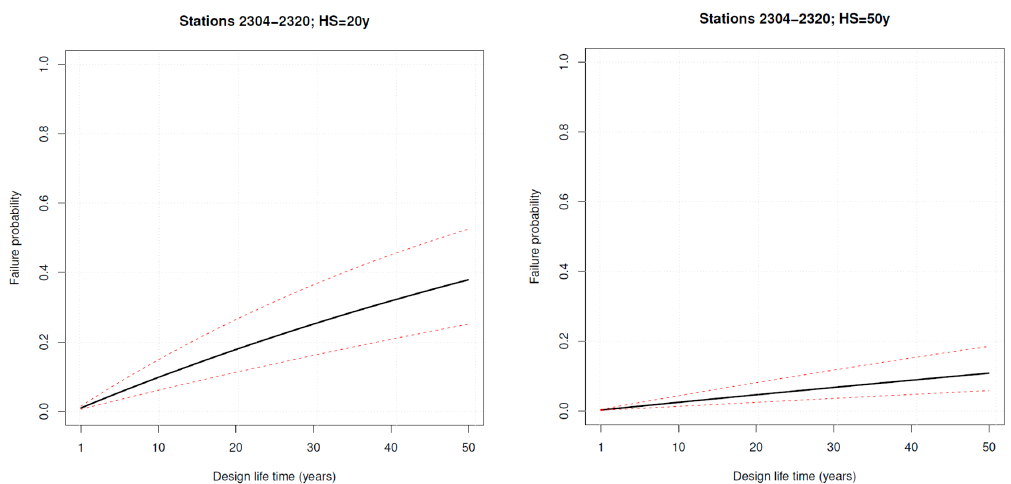
Figure 11. Upper Çoruh basin. Failure probabilities for given design life times; the dashed red lines indicate a 95% confidence band. The different plots correspond to the probability that the system enters a bivariate AND hazard scenario whose marginal critical thresholds are given by the quantiles reported in Table 5, corresponding to different return periods indicated in the main titles—see text.